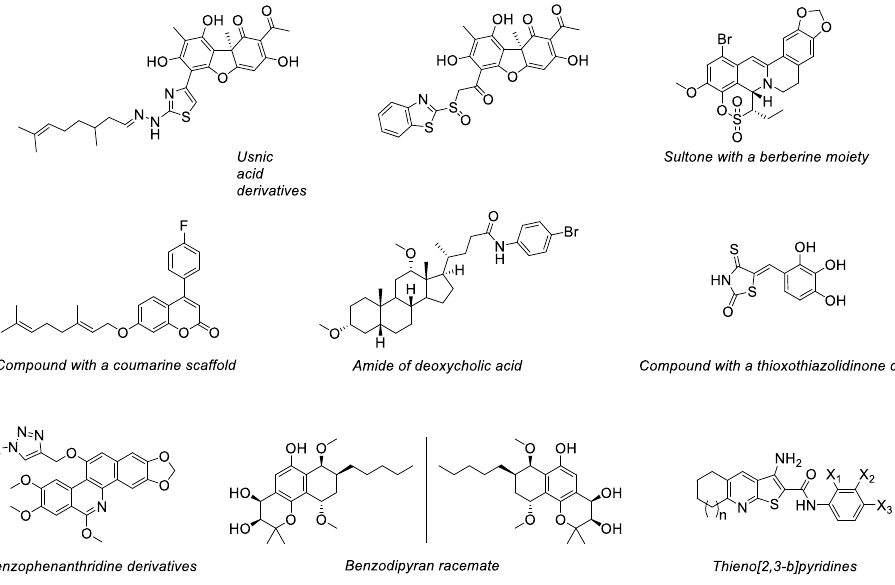
Figure 1. The structural diversity of TDP1 inhibitors.